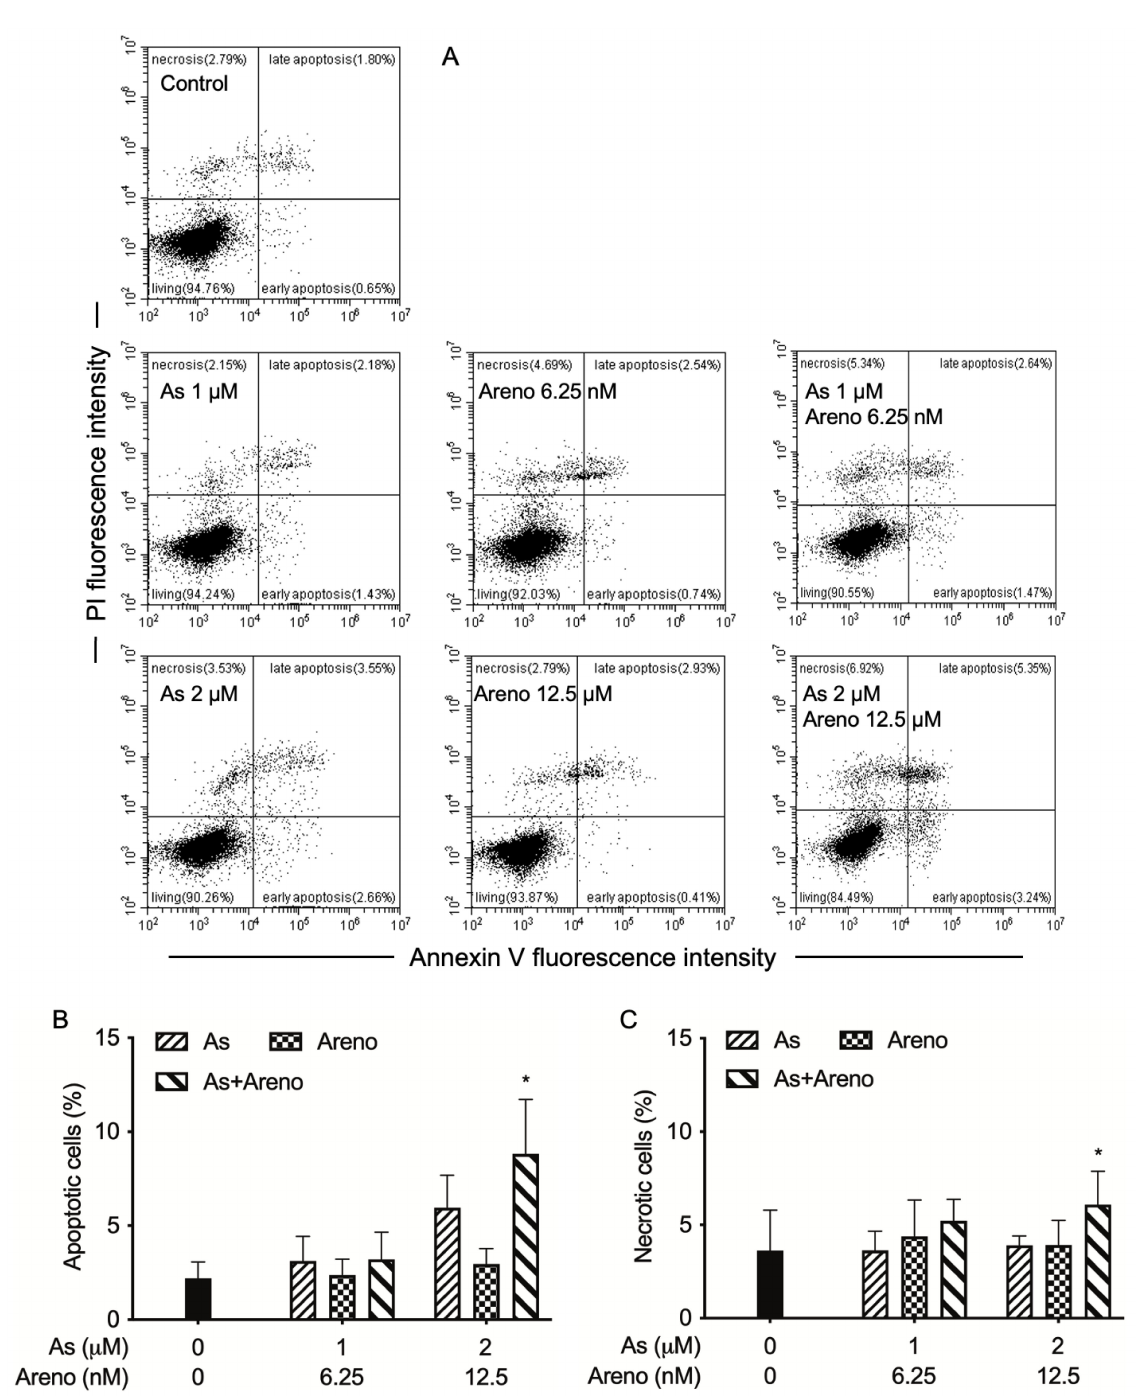
Figure 5. Apoptosis and necrosis induction in U-87 cells treated with As III and arenobufagin, alone and in combination. Following treatment for 48 h with As III (1 and 2 µ M) and arenobufagin (6.25